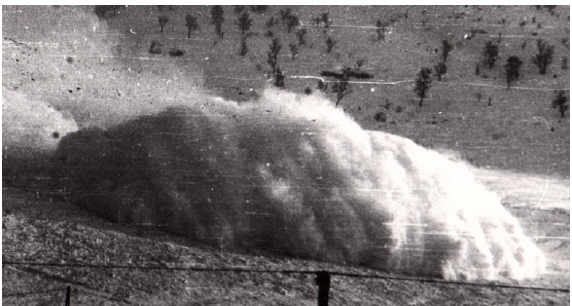
Figure 8. Powder avalanche in Khibiny moutains. Photo by Centre of Avalanche Protection of JSC “Apatit”,